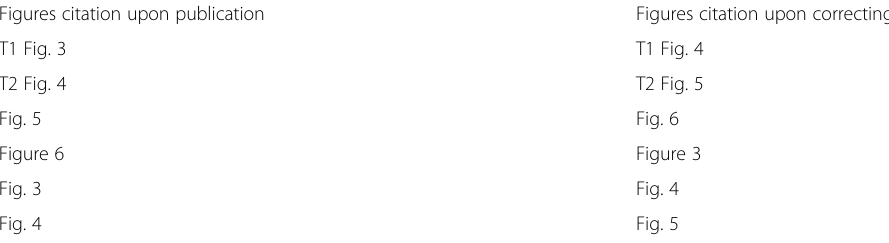
Fig. 3 Common expository instructional format (McKay 2000a p.163)